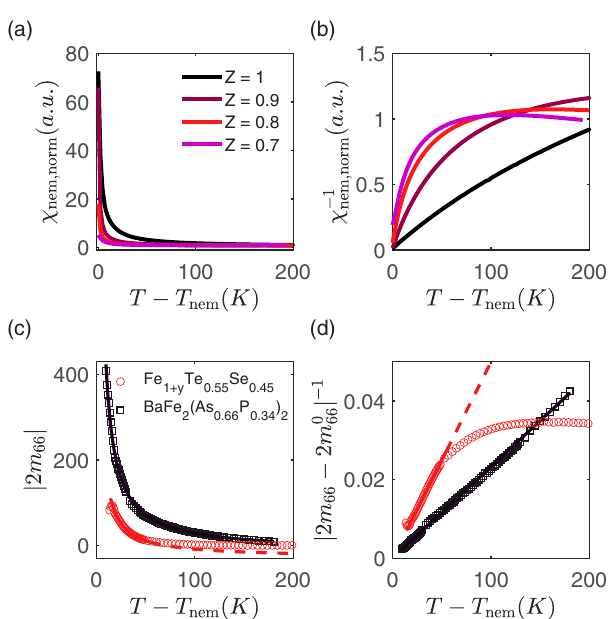
Fig. 5 Effect of orbital selectivity on nematic fl uctuations. a , b Theoretical calculation of the normalized nematic susceptibility χ nem ( a ) and its inverse ( b ), plotted as a function of the relative temperature with respect to the theoretical nematic transition temperature ( T − T nem ) for different spectral weight 0.7 ≤ Z xy ≤ 1. c , d Temperature dependence of c ∣ 2 m 66 ∣ and j (cid:2) 1 of optimally doped Fe d j 2 m 66 (cid:2) 2 m 0 1 + y Te 0.55 Se 0.45 (red circles) and 66 BaFe 2 (As 0.66 P 0.34 ) 2 (black squares). The red and black lines show Curie – Weiss fi ttings. The data for BaFe 2 (As 0.66 P 0.34 ) 2 follows a Curie – Weiss behavior all the way up to 200K, whereas for Fe 1 + y Te 0.55 Se 0.45 , it deviates from Curie – Weiss behavior above ~50